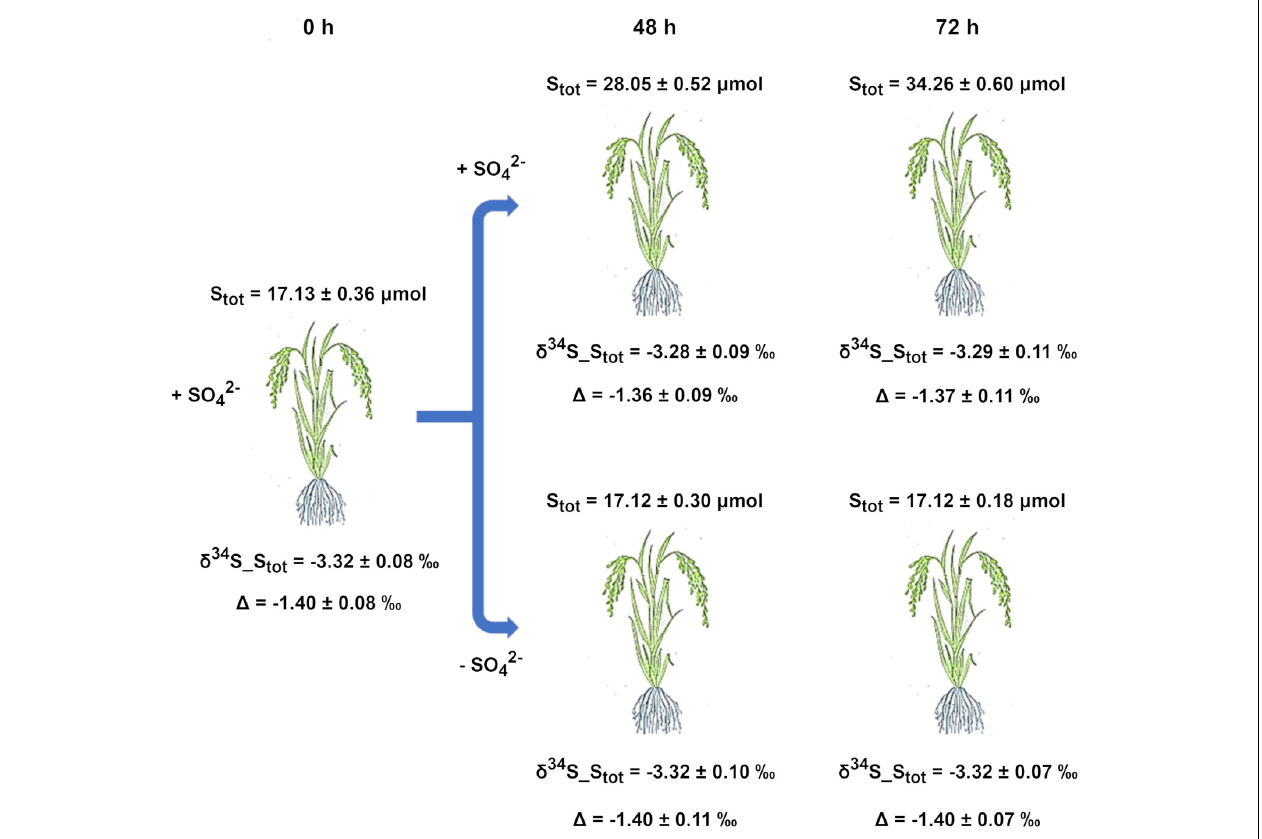
FIGURE 3 | Experimental setup and 32 S/ 34 S isotope effects associated with S partitioning and metabolism in rice plants. Plants were pre-grown in complete nutrient solutions and then continuously maintained on media containing SO 42 − or deprived of SO 42 − for 72 h (experimental setup B). S tot , total S amount in a whole plant; δ 34 S_S tot , S isotope composition of the whole plant; (cid:49) , 34 S depletion relative to the S source ( δ 34 S_SO 42 − source = − 1.92 ± 0.02 independent experiments run in duplicate ( n =